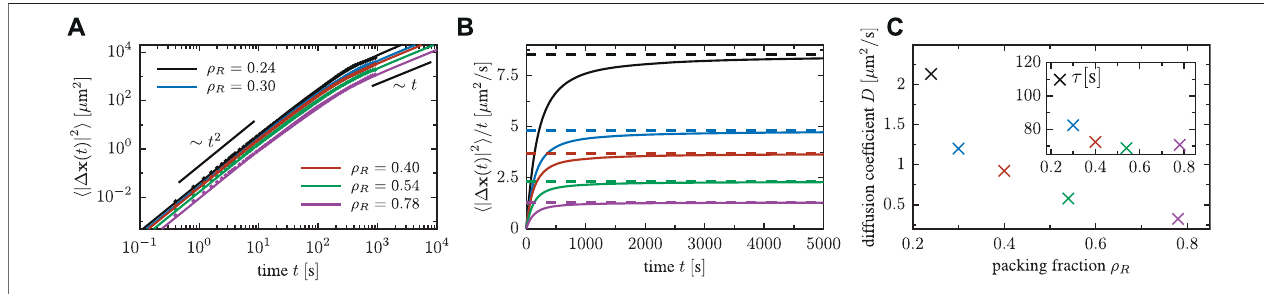
FIGURE 10 | (A) Mean square displacement of cells for a system of N = 25 cells in a box of various side length (implying various packing fractions). (B) Mean square displacement of particles, divided by time, for a system of N = 25 cells in a box of various side length. (C) Dependence of the effective diffusion coef fi cient on the packing fraction, extracted via fi tting Fürth ’ s formula tothe mean square displacement; the inset shows the decrease ofthe crossover timescale τ asa function ofthe density Eq. 5 .